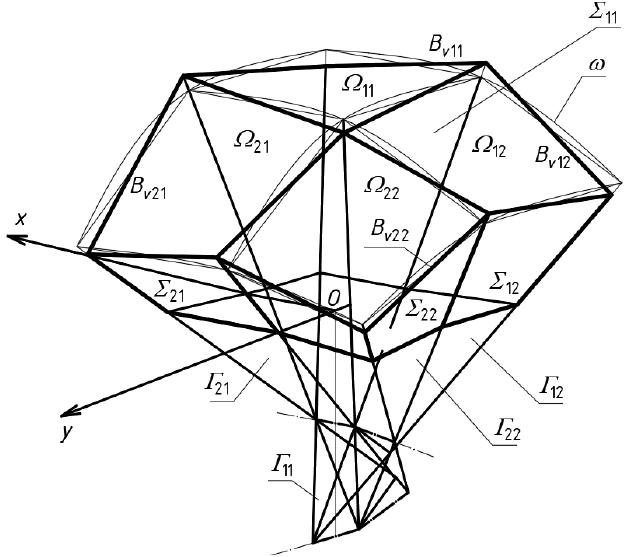
Figure 3. A free-form building structure roofed with a regular continuous shell structure characterized by the positive Gaussian curvature.